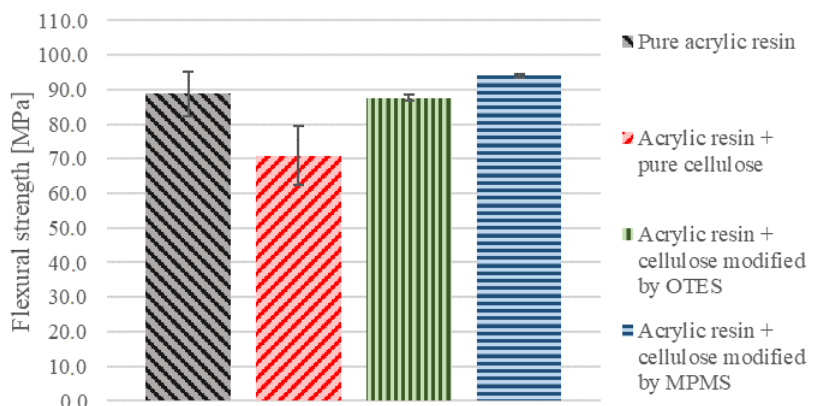
Figure 10. Flexural strength of analysed samples.